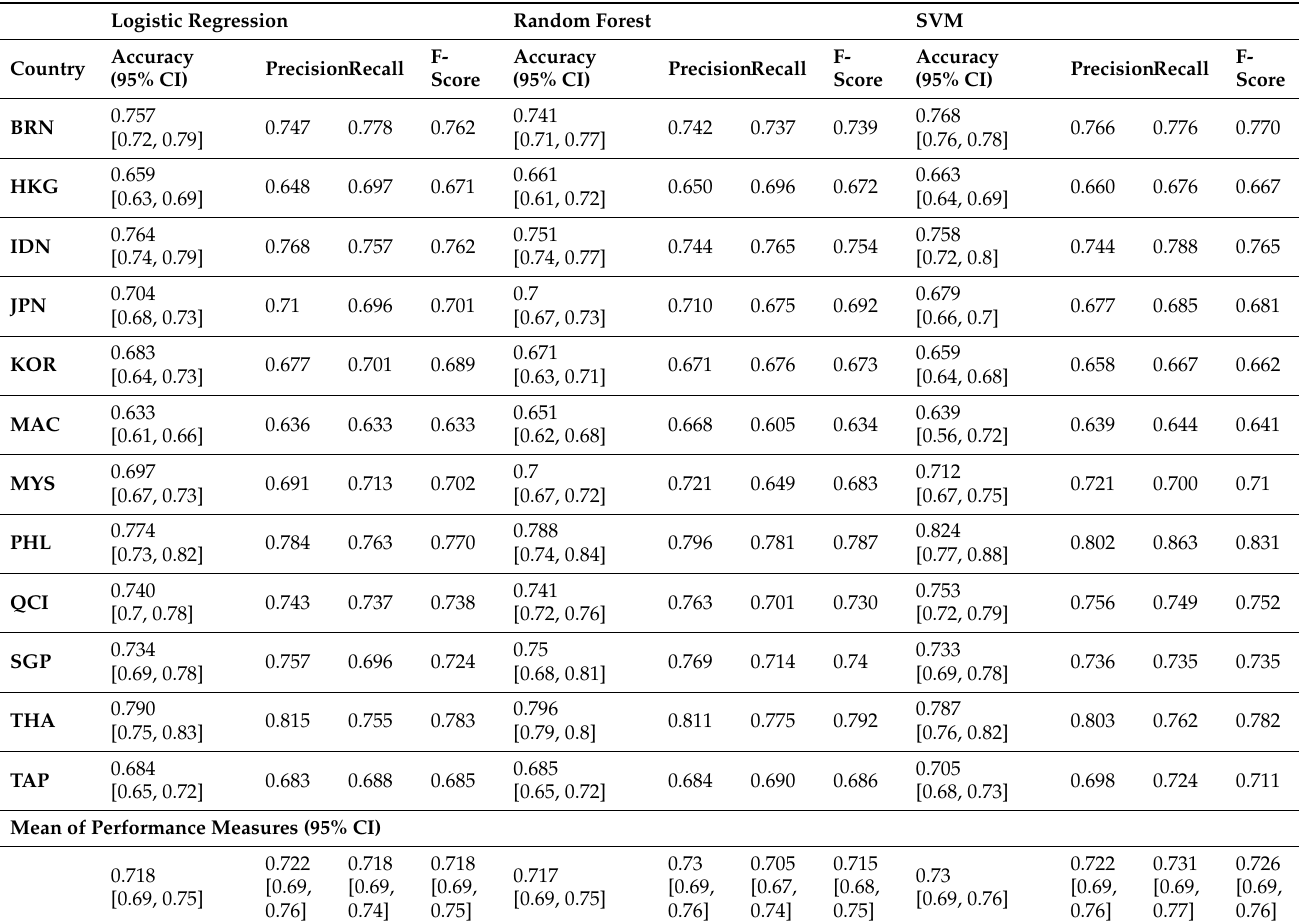
Table 5. Average results of classification performance measures based on PVs.